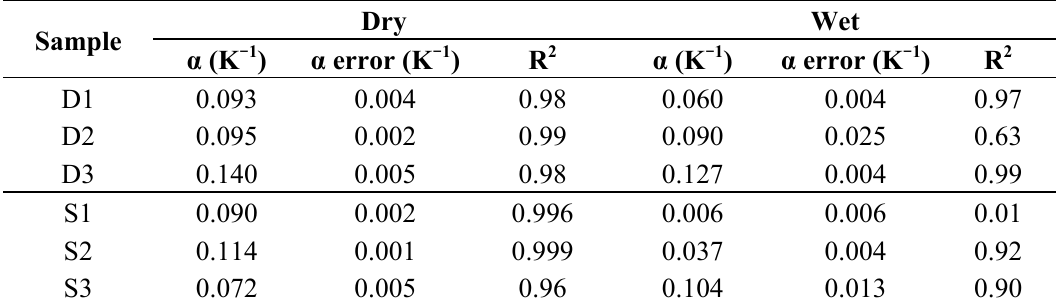
Table 1. Results of the regression between the dielectric permittivity and temperature for all soil